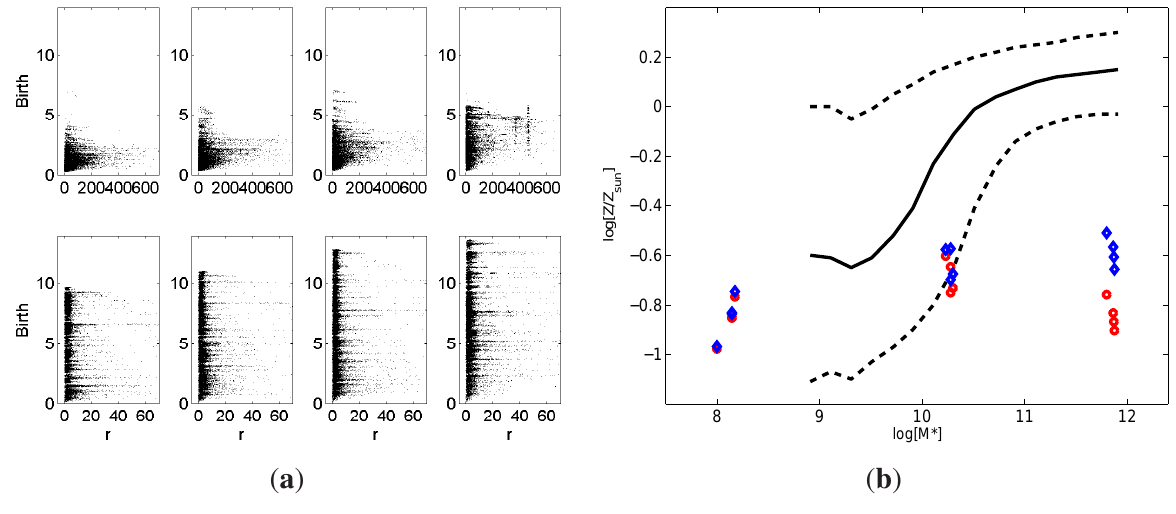
Figure 12. ( a ) Ages (in Gyr) of the "star particles" versus the radial positions (distance from the barycenter in kpc) for the high (top row) and low mass models (bottom row) and decreasing density from left to right at the final time-step of their evolution. The radial distance is calculated from the barycenter of the stellar system (kpc). The virial radii of the stellar systems are similar to the extension along the X axis; ( b ) Averaged metallicity log[ Z/Z [ M ] for the models of Table 1, compared ] versus stellar mass log M ∗ ⊙ ⊙ to the observed mass-metallicity relation. Black lines: data from [184] (solid line: median distribution of their sample; dashed lines: 16th and 84th percentiles). Red open circles: averaged metallicity of all stellar particles in each model. Blue open circles: averaged metallicity within the inner 5 kpc in each model. Reproduced with permission from